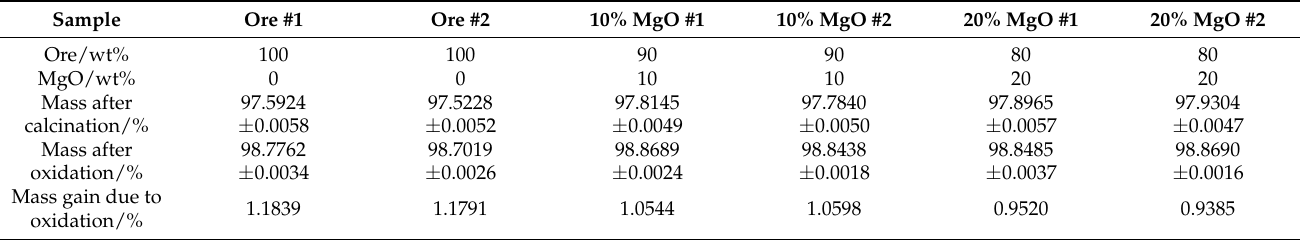
Table 5. Mass of chromite and chromite-MgO-mixtures after calcination and after oxidation.